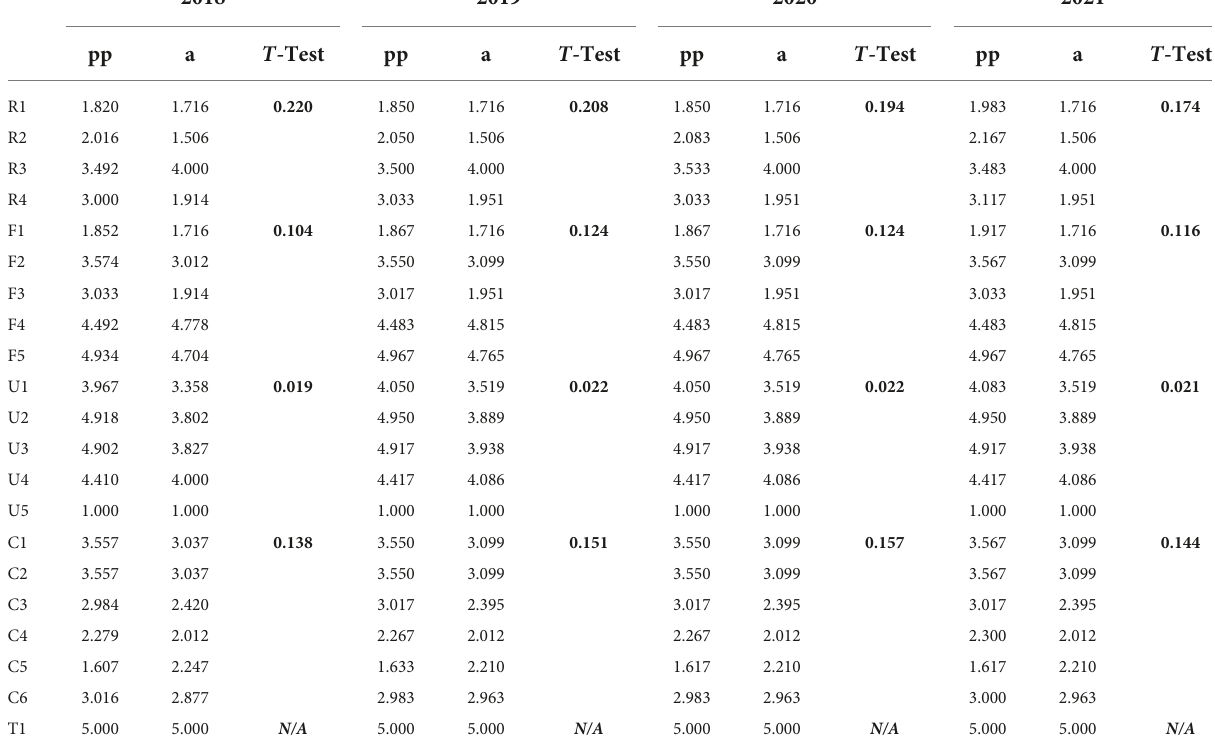
TABLE 1 Statistical test